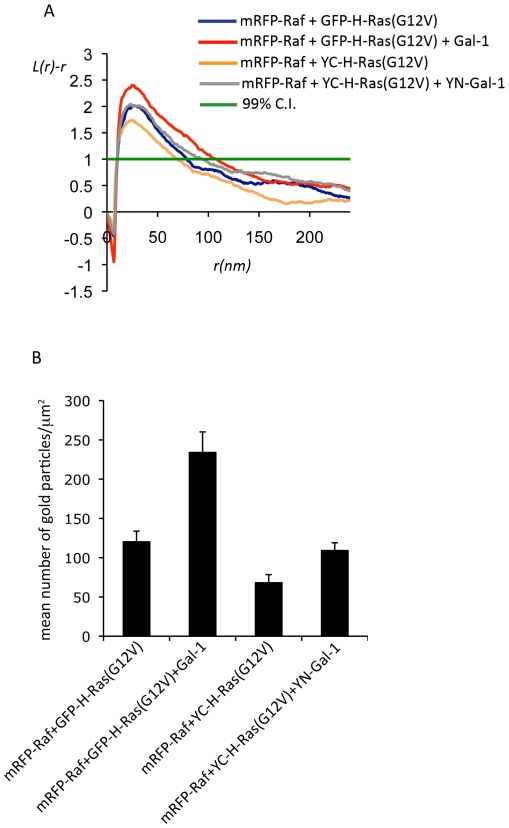
Expression of Gal-1 increases Raf recruitment to the inner leaflet of the plasma membrane by H-RasG12V.Plasma membrane sheets were generated from serum-starved cells expressing the following combinations of constructs: GFP-H-RasG12V/mRFP-Raf, GFP-H-RasG12V/mRFP-Raf/Gal-1, YC-H-RasG12V/mRFP-Raf and YC-H-RasG12V/YN-Gal-1/mRFP-Raf. The plasma membrane sheets were labeled with anti-mRFP antibody conjugated to 5 nm gold to detect mRFP-Raf plasma membrane recruitment. A. The spatial distribution of the gold labelling was analyzed using Ripley's K-function. Maximum L(r)-r values above the 99% confidence interval (CI) for complete spatial randomness (CSR) indicate clustering at the value of r (supr). Univarate K-functions are weighted means (n>8) standardized on the 99% CI. B. Analysis of the number of mRFP-Raf proteins recruited to the plasma membrane. Bars represent the mean number of gold particles/µm2 (± SEM).